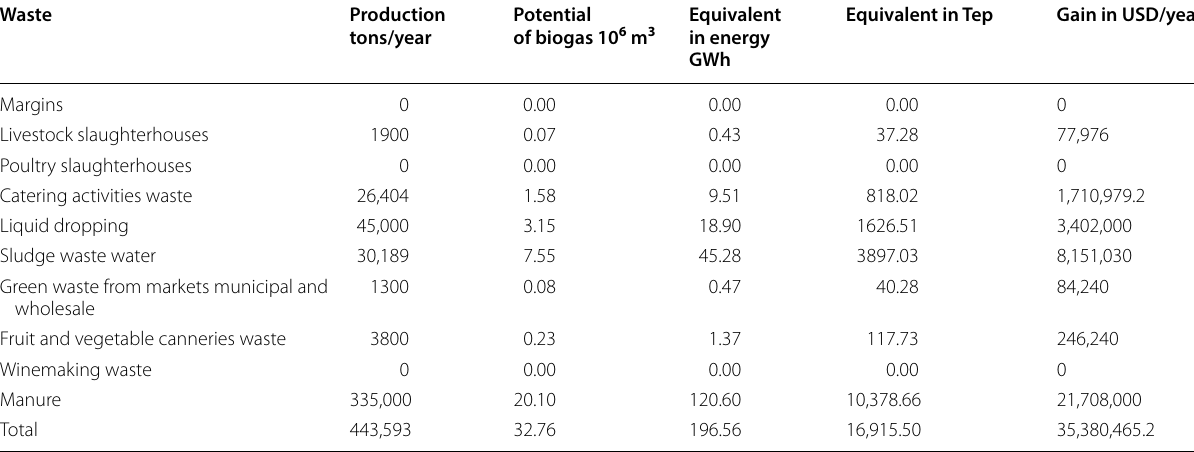
Table 6 Potential of biogas in the Midwest of Tunisia Waste